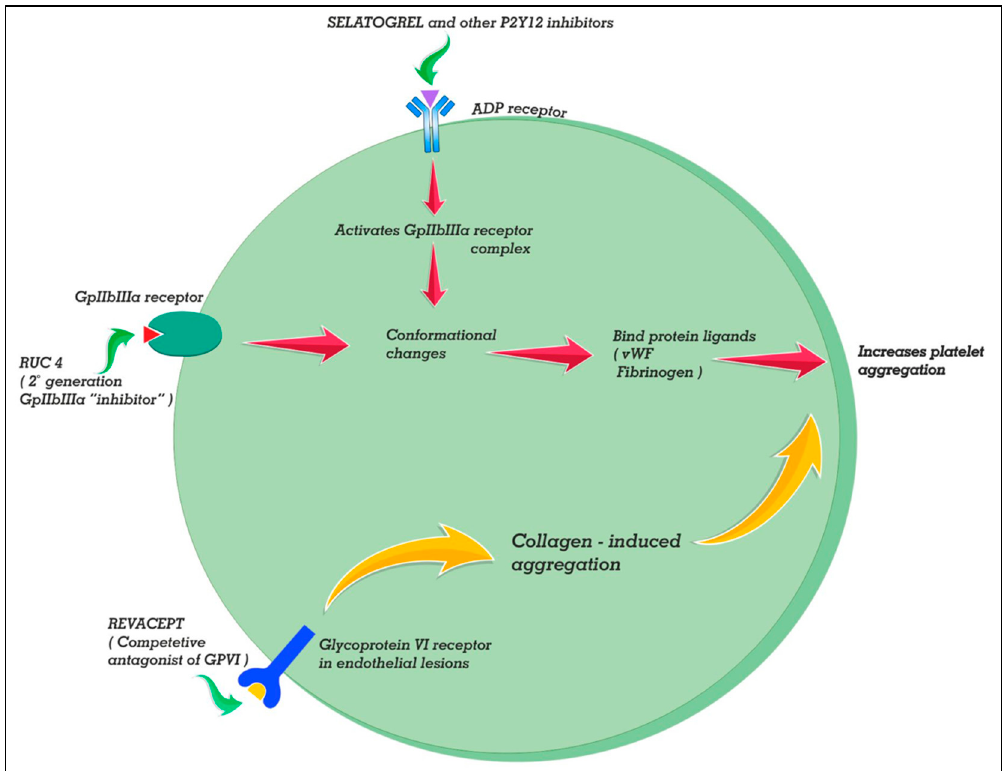
Figure 3. Mechanism of action of three novel antiplatelet drugs in the making. Selatogrel (ACT- 246475) is a novel 2-phenylpyrimidne-4-carboxamide analogue that reversibly inhibits P2Y12 recep- tors. It can be administered subcutaneously for early, pre-hospital treatment of acute coronary syn- drome. Revacept is a fusion molecule of extracellular domain of the GPVI receptor and human Fc-segment. It inhibits collagen-mediated platelet adhesion and aggregation selectively at the site of plaque rupture. RUC-4 is a second-generation Gp IIb/IIIa inhibitor with a subcutaneous node